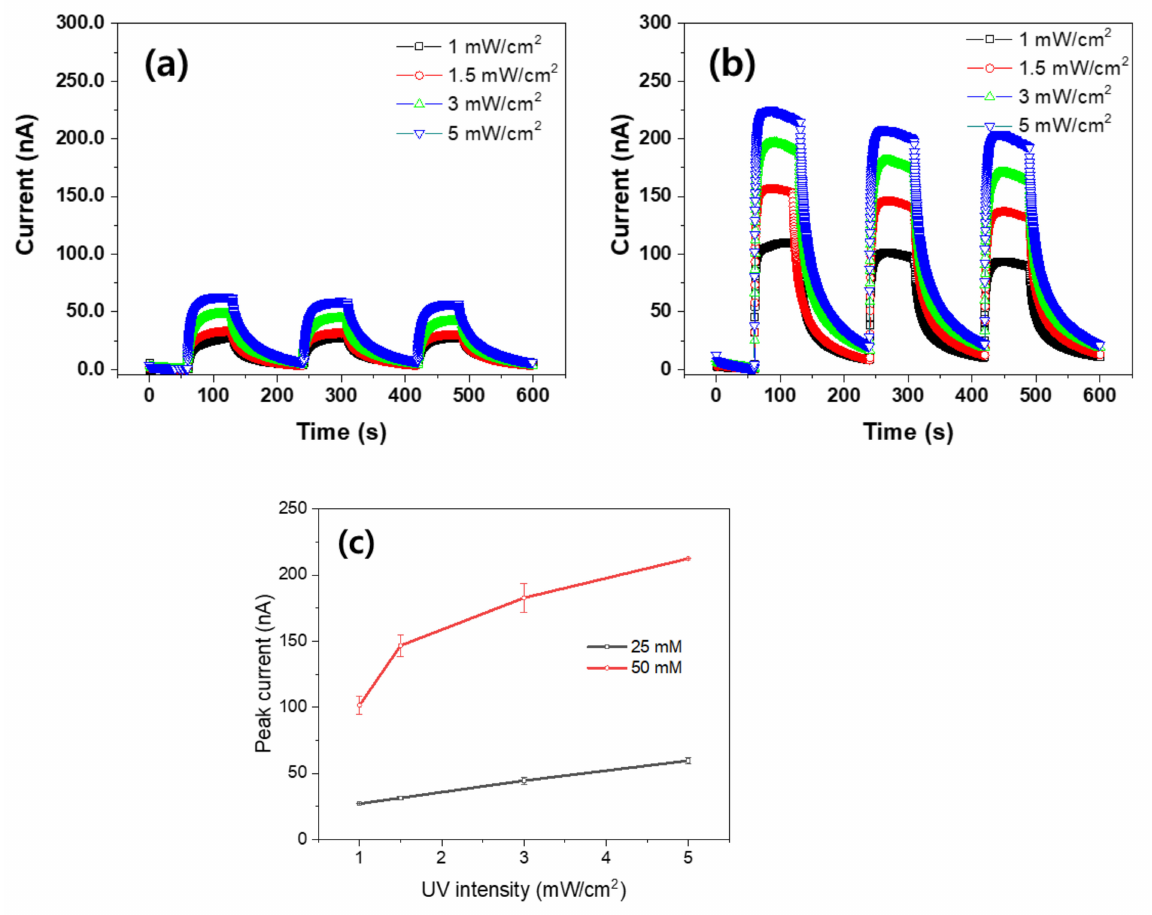
Figure 8. Induced current outputs of ZCNs: ( a ) 25 mM ZCN, ( b ) 50 mM ZCN, and ( c ) the UV irradiance intensity effect.